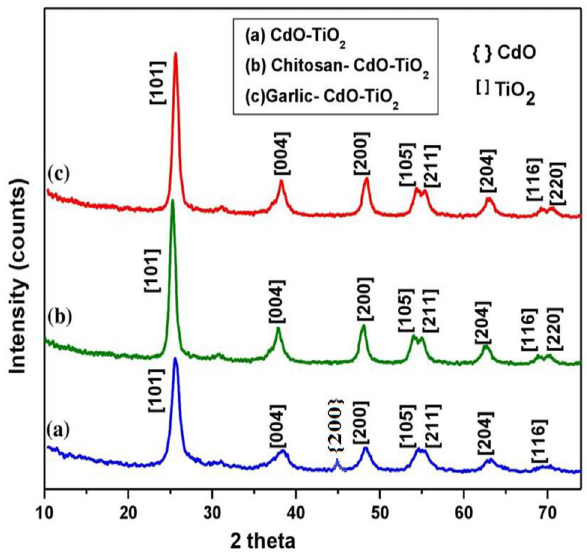
Figure 1. XRD of ( a ) CT ( b ) CS-CT and ( c ) AS-CT